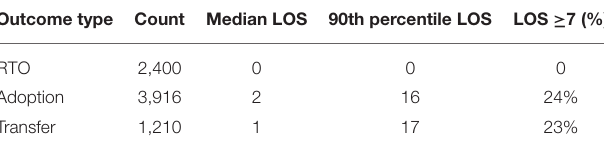
TABLE 2 | Summary statistics of LOS post a 5-day hold period (in days) for different outcome types and the percentage of dogs who stayed at least a week per group.